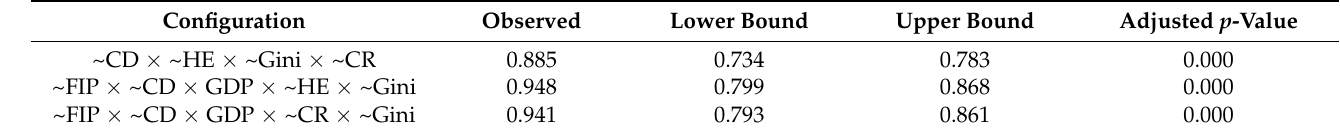
Table 8. Consistency for low energy consumption efficiency performance.